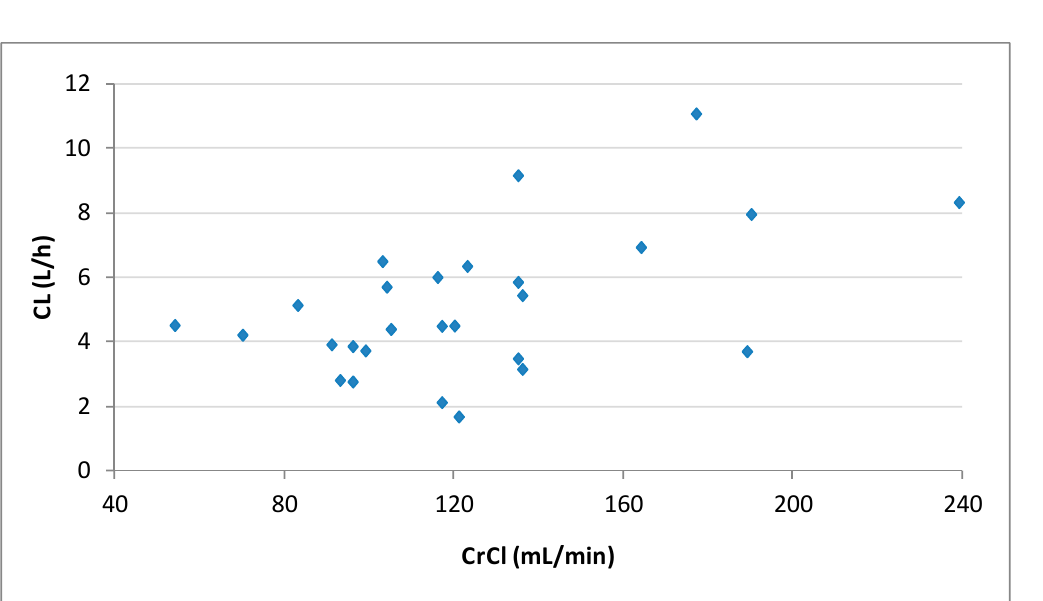
Table 2. Levetiracetam pharmacokinetic parameters (mean and standard deviation) at steady state following intravenous administration of 500–1500 mg every 12 h to critically ill patients.